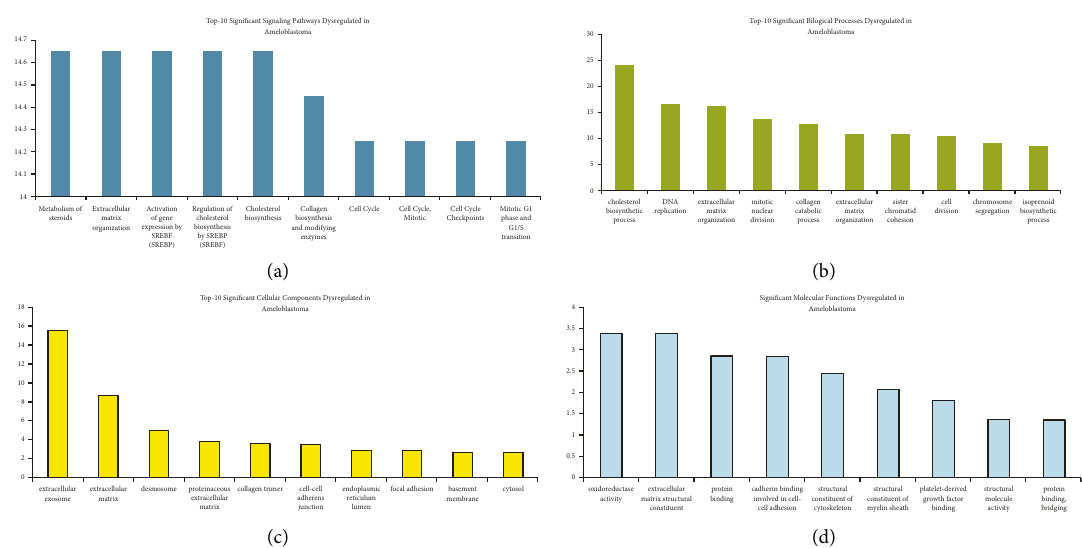
Figure 4: Gene regulatory network. Red and green circles represent up- and downregulated hub genes, respectively. Blue diamonds demonstrate TFs, while yellow rectangles show miRNAs. The violet hexagon illustrates the protein kinase enriched by the TFs. TF, transcription factor.